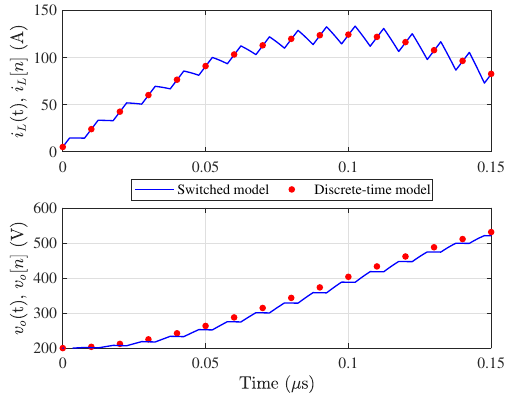
Figure 7. Comparison between the evolution of the state variables from the approximate discrete-time model and from the switched model implemented in PSIM c (cid:13) software. V g = 200 V, T = 10 µ s, L = 326 µ H and d [ n ] = D =